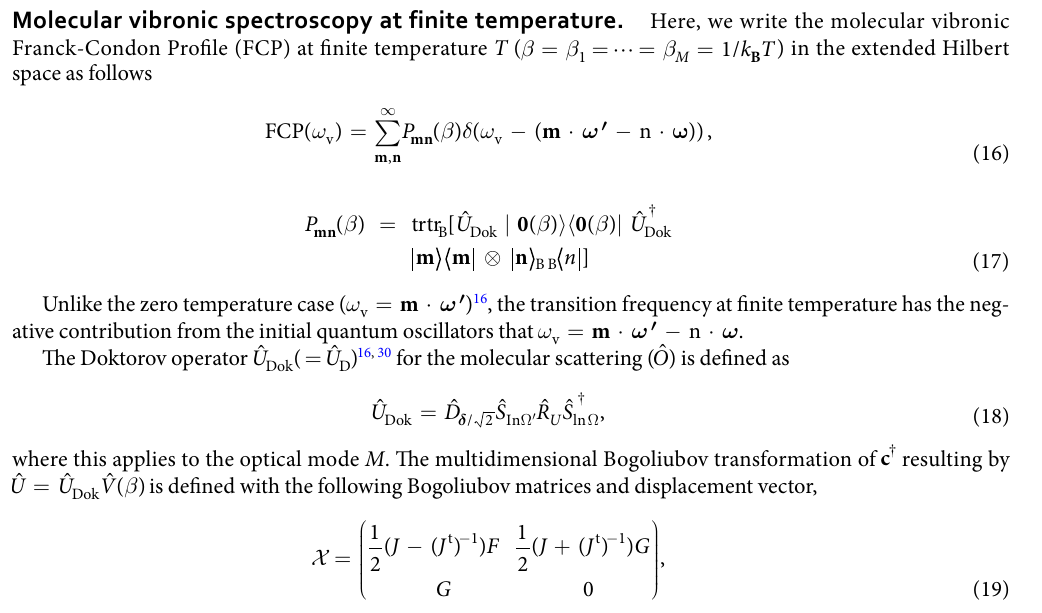
Figure 1. Gaussian Boson Sampling device for thermal states. ( a ) The uncorrelated squeezed thermal state ρ ) enters into linear photon network. The output Fock states (| m 〉〈 m |) are detected, and the input number ( ˆ ˆ † S S th states are not resolved. ( b ) The correlated squeezed thermal state ( ρ ˆ ˆ ˆ ˆ † † SR R S The output Fock states (| m 〉〈 m |) are detected, and the input number states are not resolved. ( c ) The thermal state is prepared as a pure state in the extended Hilbert space with the ancillary modes. The input states are prepared as uncorrelated squeezed coherent or vacuum input states. Both of output ((| m 〉〈 m |) and input ( n n ) Fock states are resolved via measuring the photon output of the extended optical BB